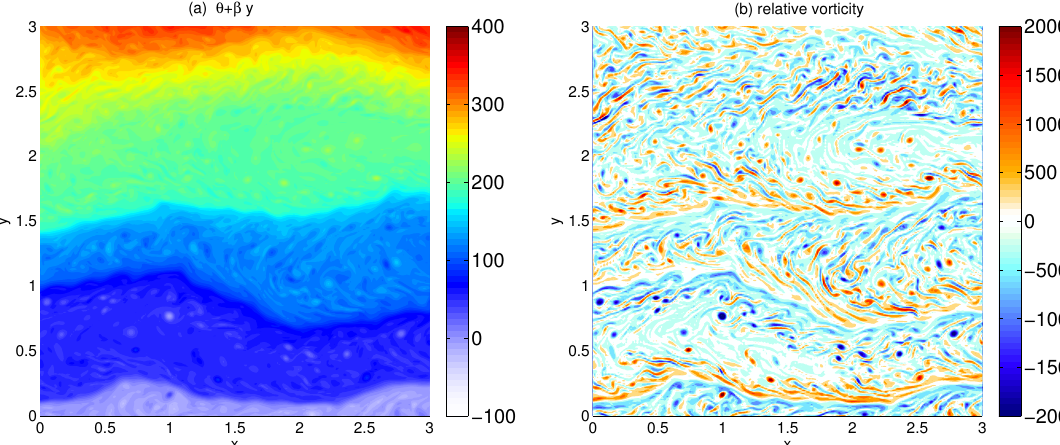
Figure 3. ( a ) Surface buoyancy θ + β y in a forced Surface Quasi-Geostrophy (SQG) simulation in the presence of a β effect; ( b ) corresponding relative vorticity. Only a subdomain is shown. The model is forced at wavenumber k f = 40 for a domain size of [ 0, 2 π ] × [ 0, 2 π ] and a resolution of 512 ×